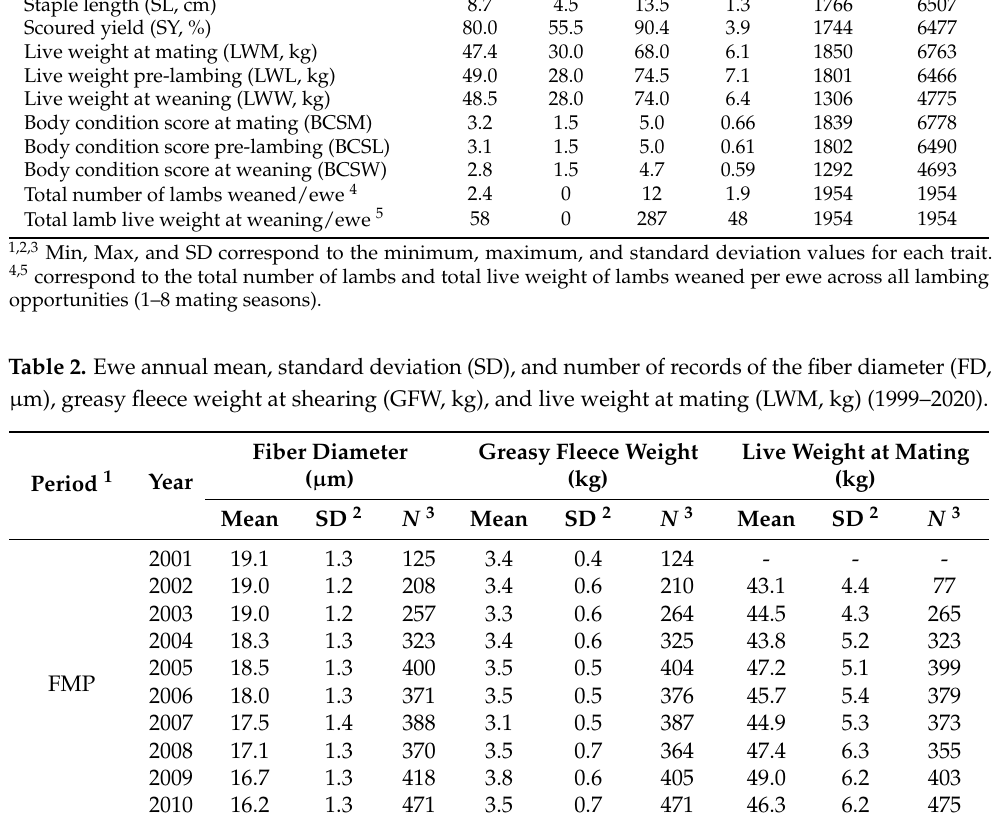
Table 1. Descriptive statistics for mixed-age ewe wool, growth, and reproductive traits over the entire study period (1999–2020).